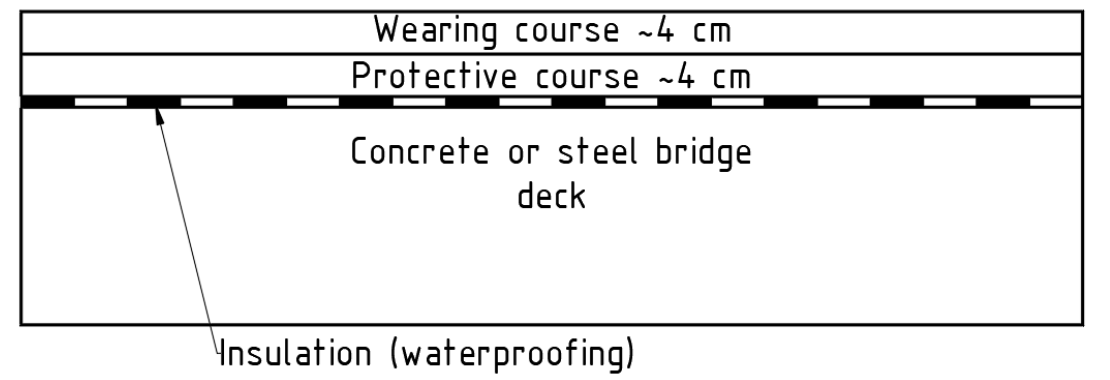
Figure 1. Typical arrangement of pavement layers on the bridge deck.